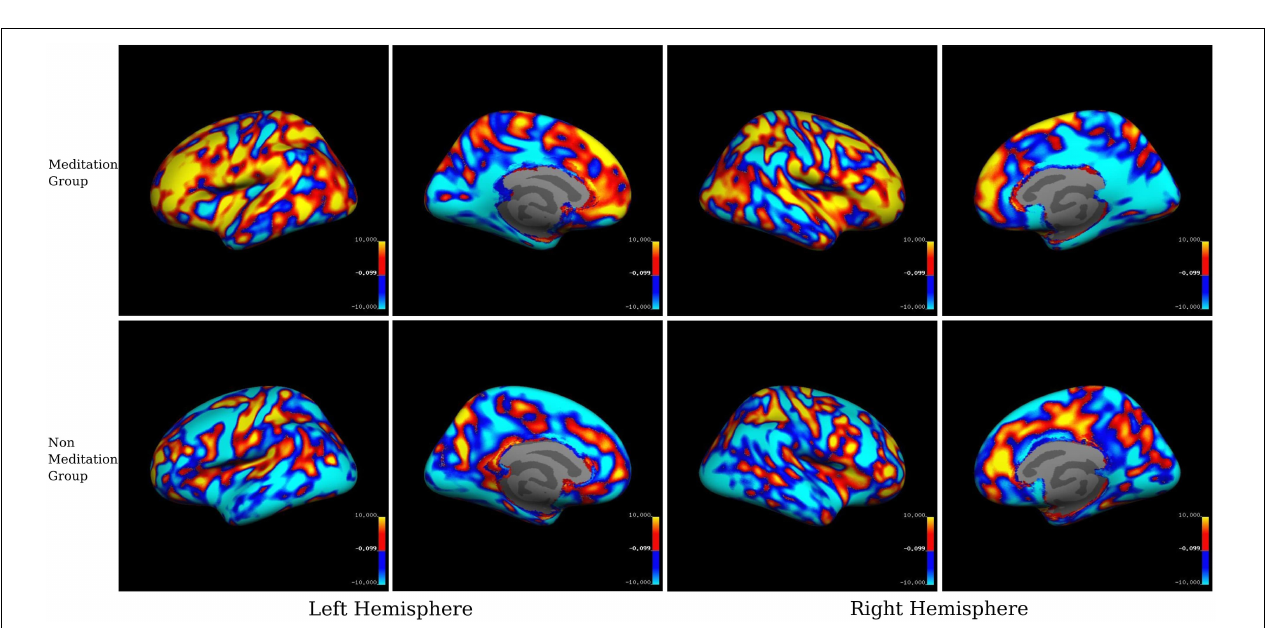
FIGURE 3 | Within-group averaged SPC changes for cortical thickness in the meditation (Group1) and the non-meditation (Groups2+3) groups. Positive values (red-yellow) correspond to the increased cortical thickness and negative values (light blue-dark blue) corresponds to decreased cortical thickness. The voxels with SPC between –0.1 and +0.1 have been left uncolored. The top panel represents the meditation group while the lower panel represents the non-meditation group.